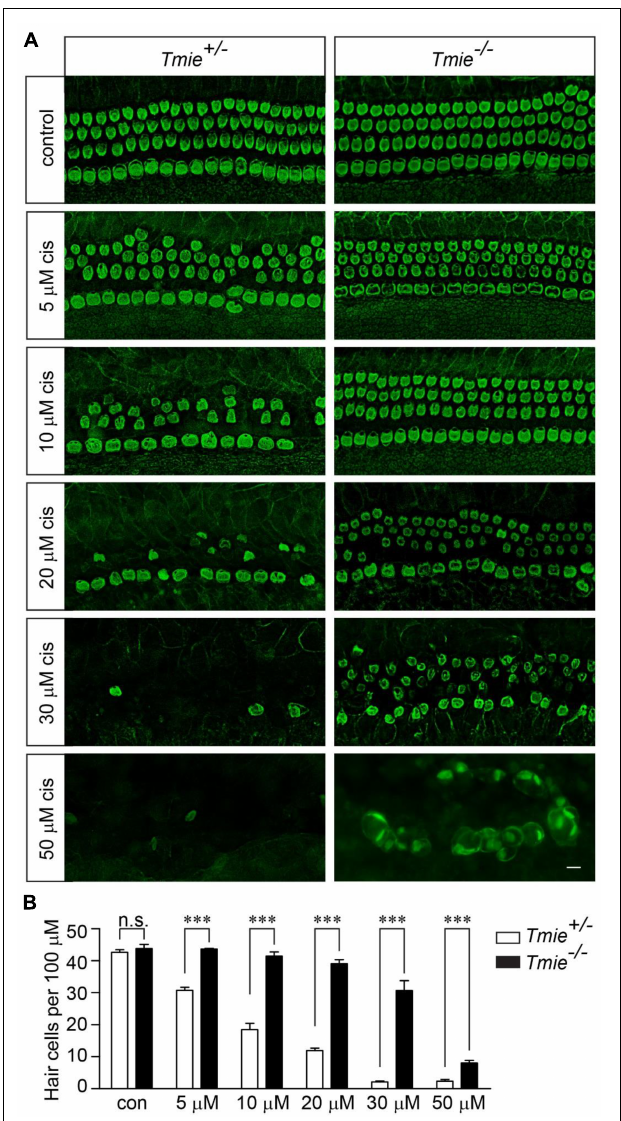
FIGURE 2 | Tmie mutant hair cells are more resistant to cisplatin ototoxicity. (A) Cochlear explants were dissected from P3 Tmie ± and Tmie − / − mice and then exposed to cisplatin at different concentrations for 2 days. The samples were fixed and labeled with an antibody against β 2-spectrin. The majority of the Tmie − / − hair cells were dead with a few swollen hair cells in the explants, after the exposure to 50 µ M of cisplatin for 2 days. Note, the Tmie − / − hair cells are more resistant to cisplatin ototoxicity. Scale bar: 10 µ m. (B) Numbers of hair cells per 100 µ m in the middle region of the cochlea (5 mice per group, control; 3 mice per group, 5 µ M cisplatin; 7 mice per group, 10 µ M cisplatin; 4 mice per group, 20 µ M cisplatin; 4 mice per group, 30 µ M cisplatin; 3 mice per group, 50 µ M cisplatin). Data are represented as the mean ± SE. n.s., not significant; ∗∗∗ p < 0.001 by Student’s t -test.